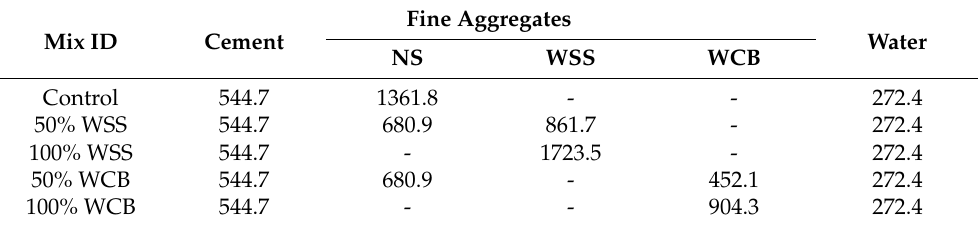
Table 2. Mix design of mortar mixes (kg/m 3 ).